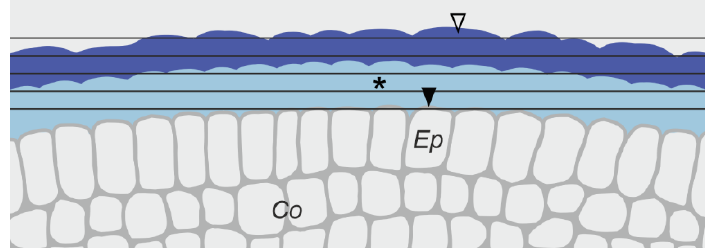
Figure 3. Schematic representation of the epidermal surface imaging with the use of the confocal laser scanning microscope. Black straight lines indicate the optical planes at which fluorescence was captured. The individual layers of the epidermal surface, the L1, L2 and L3, are demarcated by a solid arrowhead, asterisk and empty arrowhead, respectively. Ep immature epidermis, Co cortex.